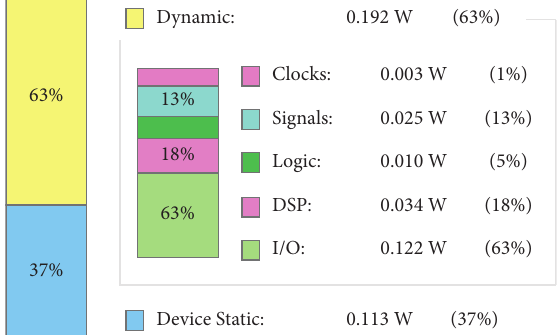
Figure 10: Power utilization of the FPGA implemented 4D PWL hyperjerk